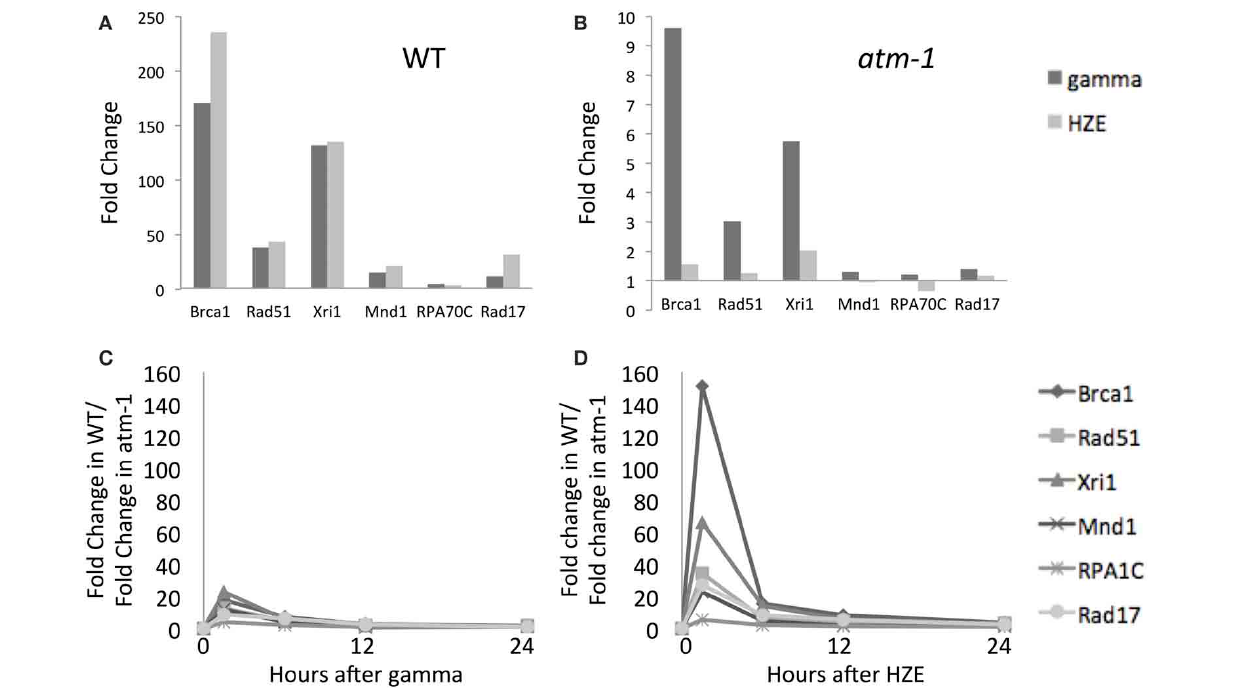
vertical bars) in WT (A) or atm-1 (B) seedlings. The ratio between the fold changes of expression for WT and atm-1 was calculated at 1.5, 6, 12, and 24h after treatment with gamma radiation (C) or HZE (D)